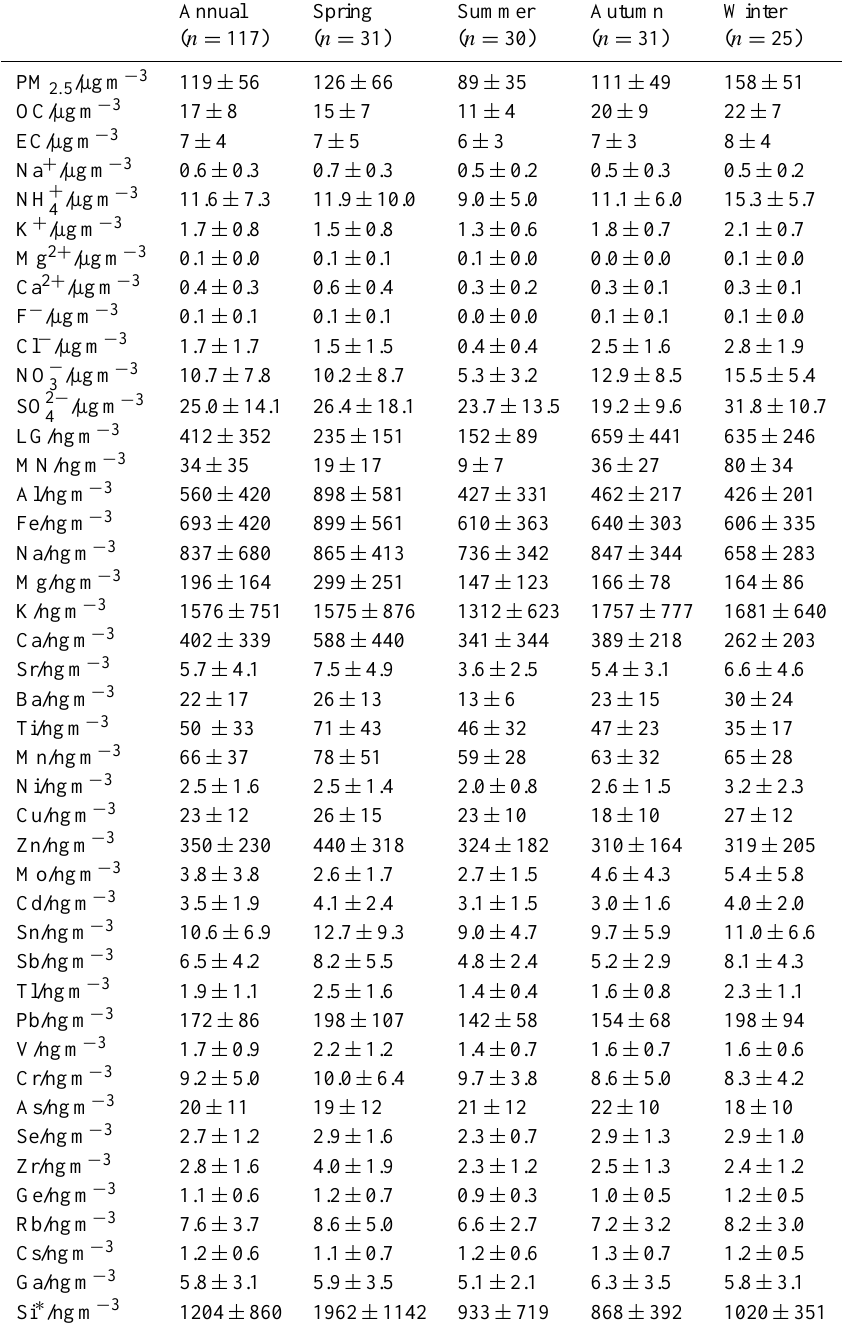
Table 2. Statistics of PM 2 . 5 chemical components in four